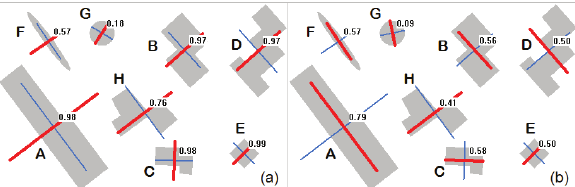
Figure 1: Building orientation measures: (a) wall statistical weighting; (b) adaptation in this approach (output orientations are in bold lines with confidence values numbered